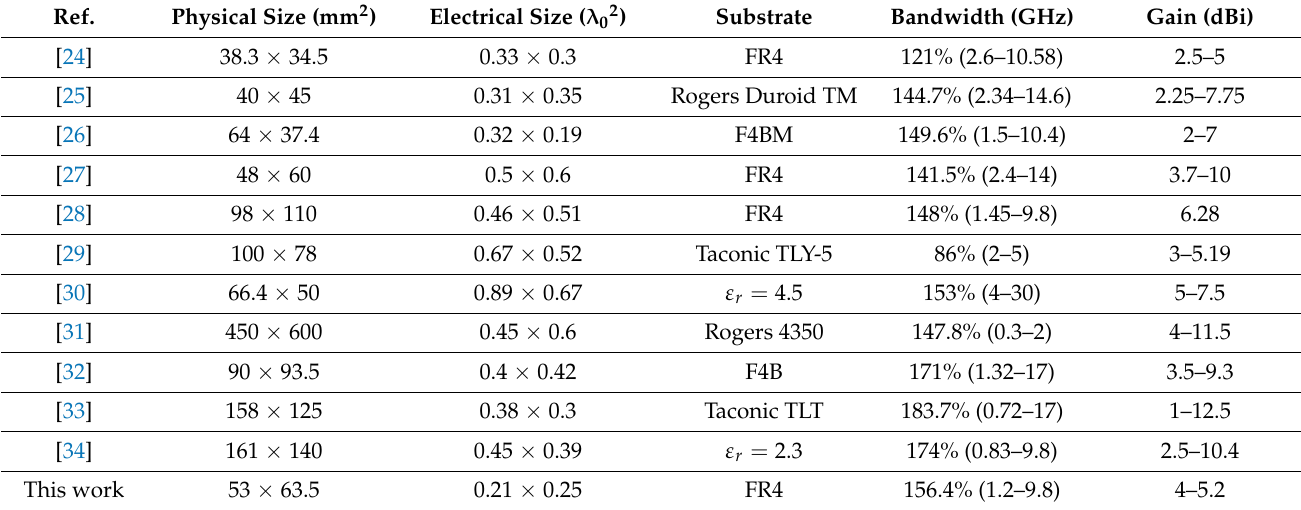
Table 2. Comparison of the proposed and reference